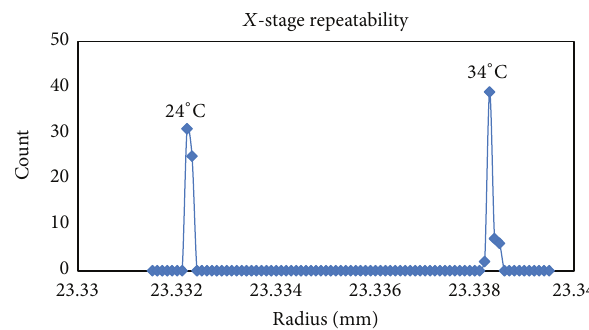
Figure 3: The frequency count plot of the 𝑋 -stage position, with a bin size of 0.001 mm, that the 𝑋 -stage must be moved to in order for the target defect to be in the middle of the microscope view. The two peaks correspond to the two highly repeatable positions of 23.332 mm and 23.338 mm due to the two stabilized room temperatures. See text for more detailed description.